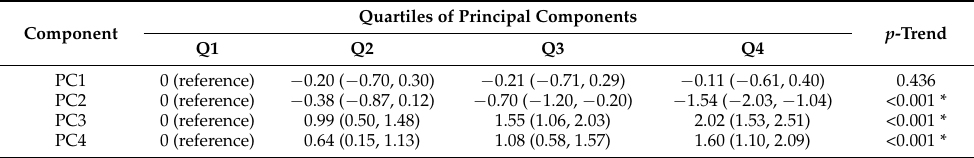
CI: confidence interval; PC: principal component. PC1: calcium, copper, and magnesium exposure pattern; PC2: